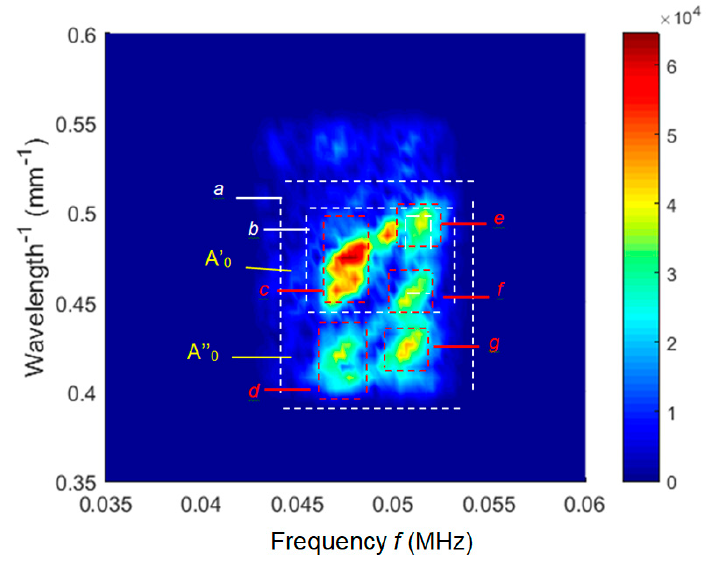
Figure 24. 2D spectrum of the air-coupled B-scan of the sample.